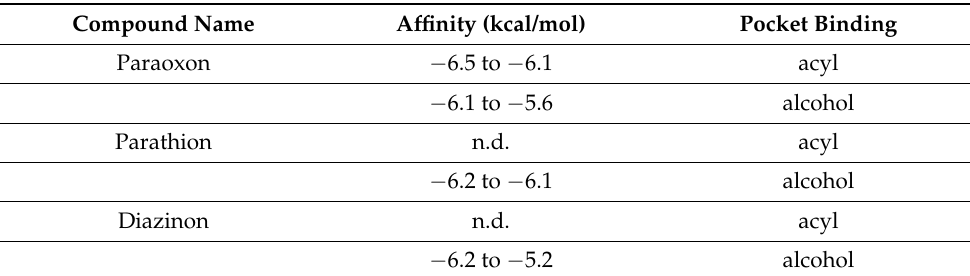
Table 1. OPs best affinity values for each of the predicted binding pockets in EST2-S35C 3D